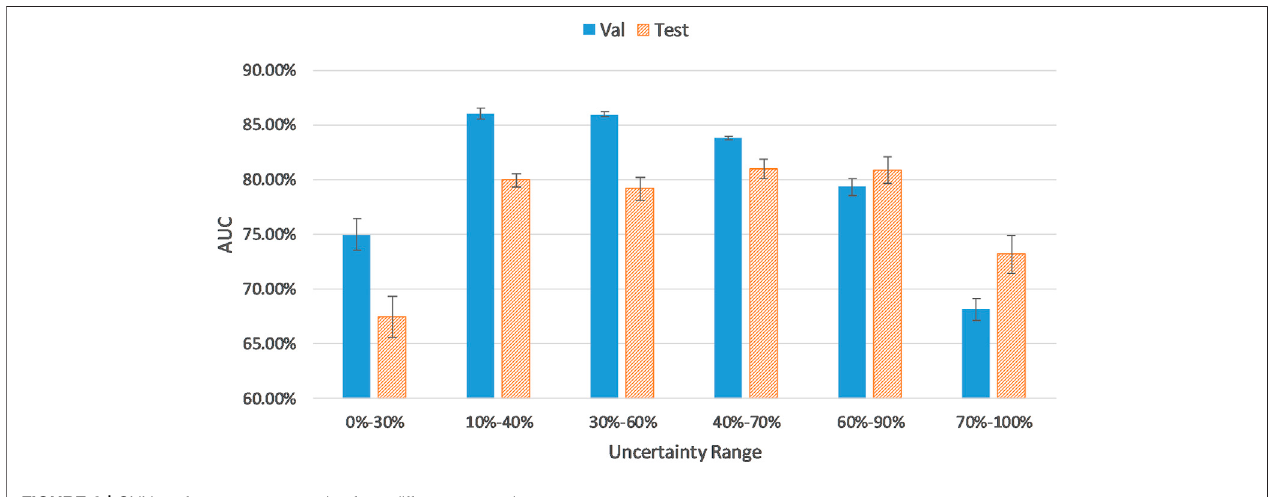
FIGURE 3 | CNN performance on samples from different uncertainty ranges.